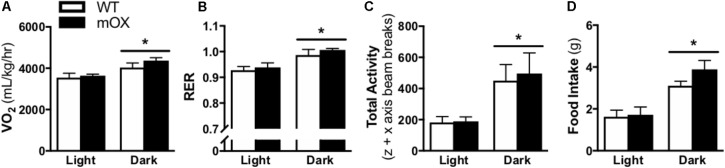
Energy expenditure, activity and food intake is comparable between p55α-mOX and WT mice. (A–D) Energy expenditure, spontaneous activity, and food intake measurements were made on male p55α-mOX and WT mice using the CLAMS system over 3 consecutive days and averages for the light and dark cycles on days 2 and 3 are presented. (A) Whole body oxygen consumption (VO2) and (B) Respiratory exchange ratio (RER) were measured by indirect calorimetry. (C) Total activity (i.e., total z + x axis beam breaks). (D) Cumulative food intake. n = 5/group. ∗p < 0.05 main effect of light cycle. Data reported as mean ± SEM.